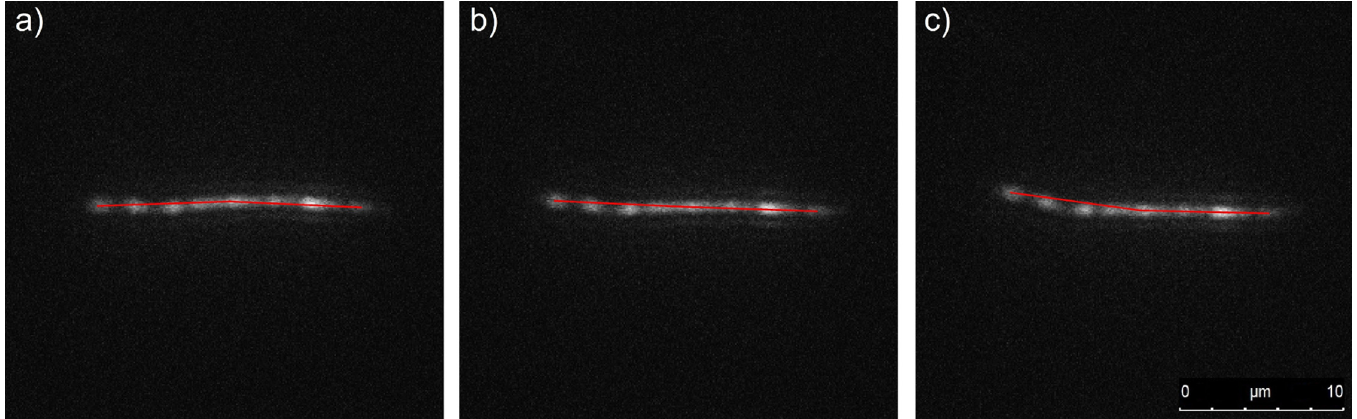
Fig 6. Fluorescence images showing bending dynamics of a nanofilament (Table 1, nanofilament no. 1). Red lines indicate arms of the fibre starting from the centre of the fibre mass. The angle between the red lines was measured to assess flexibility. The time interval between frames is t = 0.25 s.